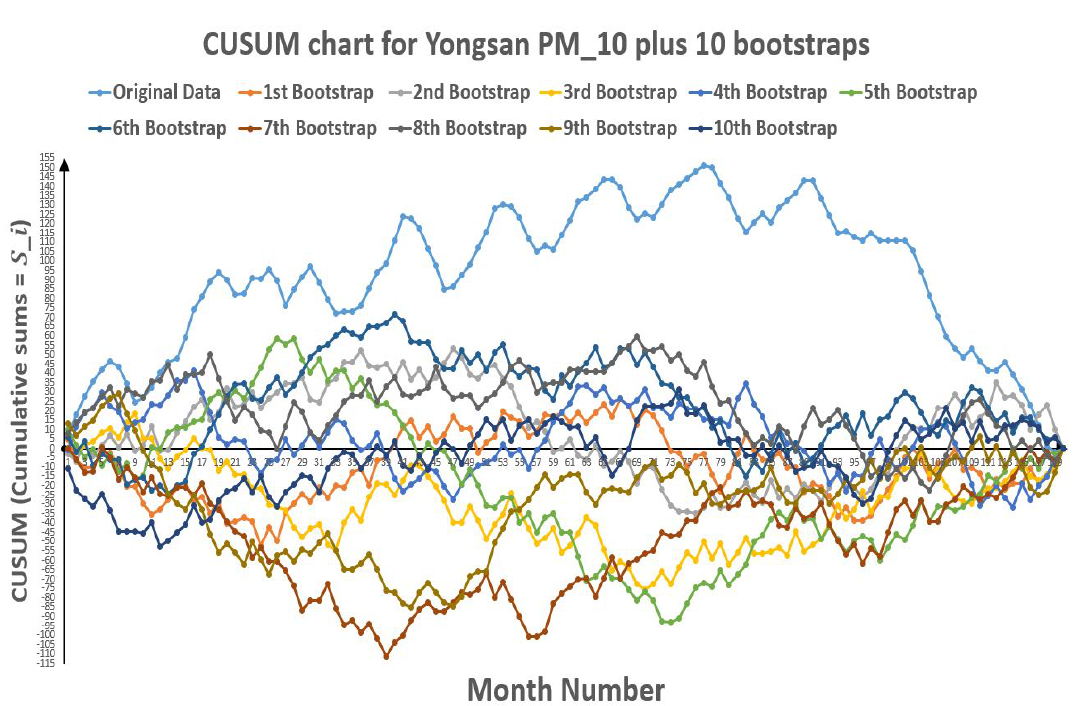
Figure 17. CUSUM chart for Yongsan PM 10 plus 10 bootstraps (European